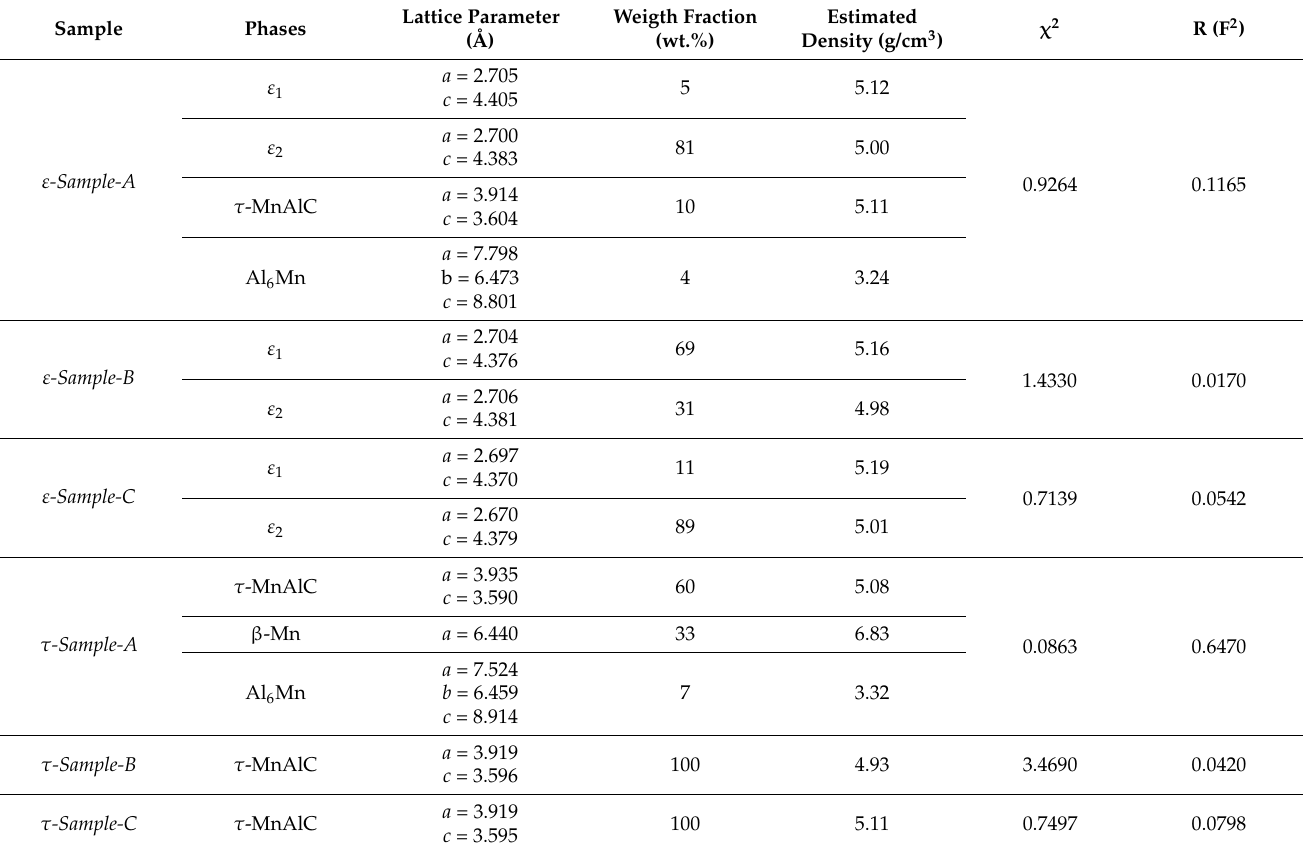
Table 1. Summary of the main parameters obtained from the Rietveld refinements for samples ε -Sample-A, ε -Sample-B and ε -Sample-C, and their resulting alloys after the annealing treatment ( τ -Sample-A, τ -Sample-B and τ